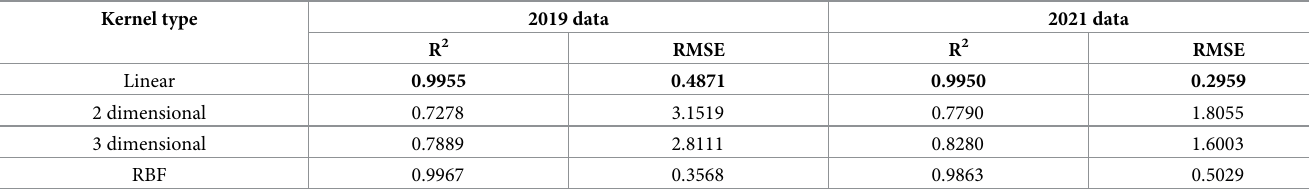
Table 12. Performance criteria of SVR models with different kernels for data of years 2019 and 2021. Kernel